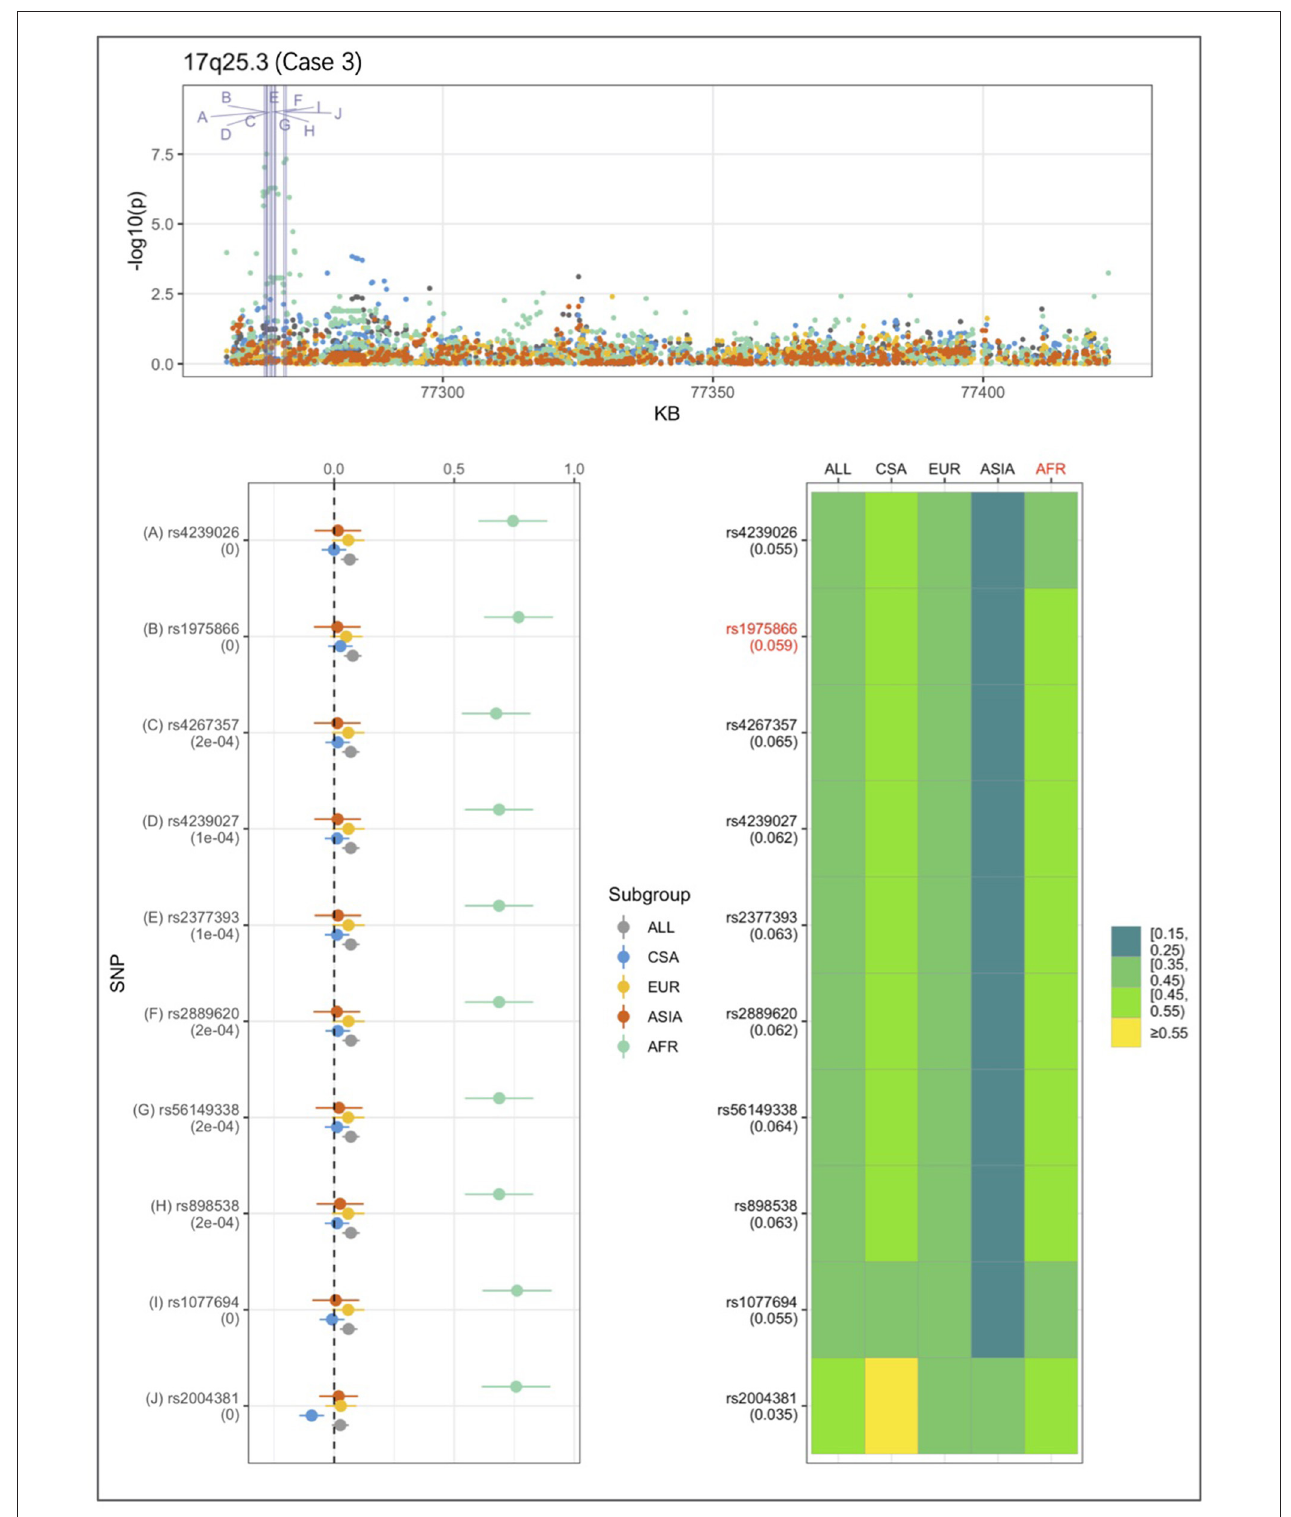
FIGURE 4 | Association peak in 17q25.3 in the AFR group consistent with category 3. SNPs are ordered by base-pair position; Q-statistic p -value noted under each SNP in forest plot; lead variant and sample with highest p -value shown in red in heatmap, and F ST values noted under each SNP.